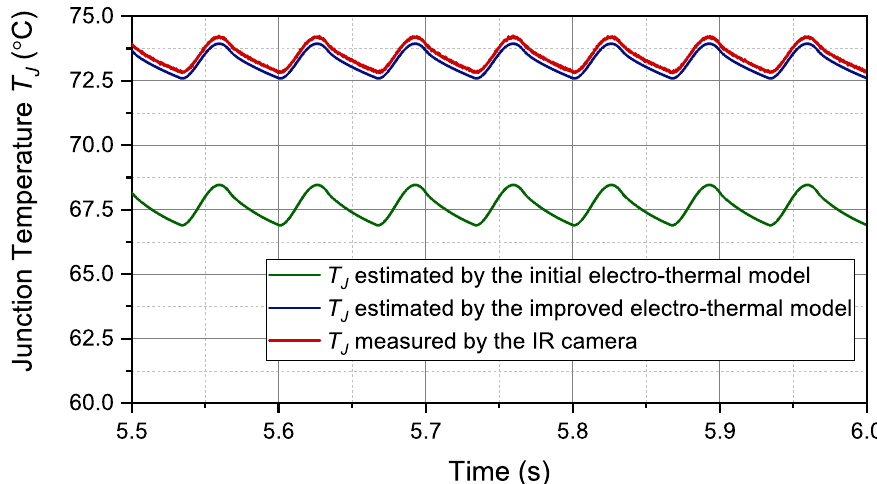
Figure 11. T J estimated by the electro-thermal model in comparation with that from IR camera.